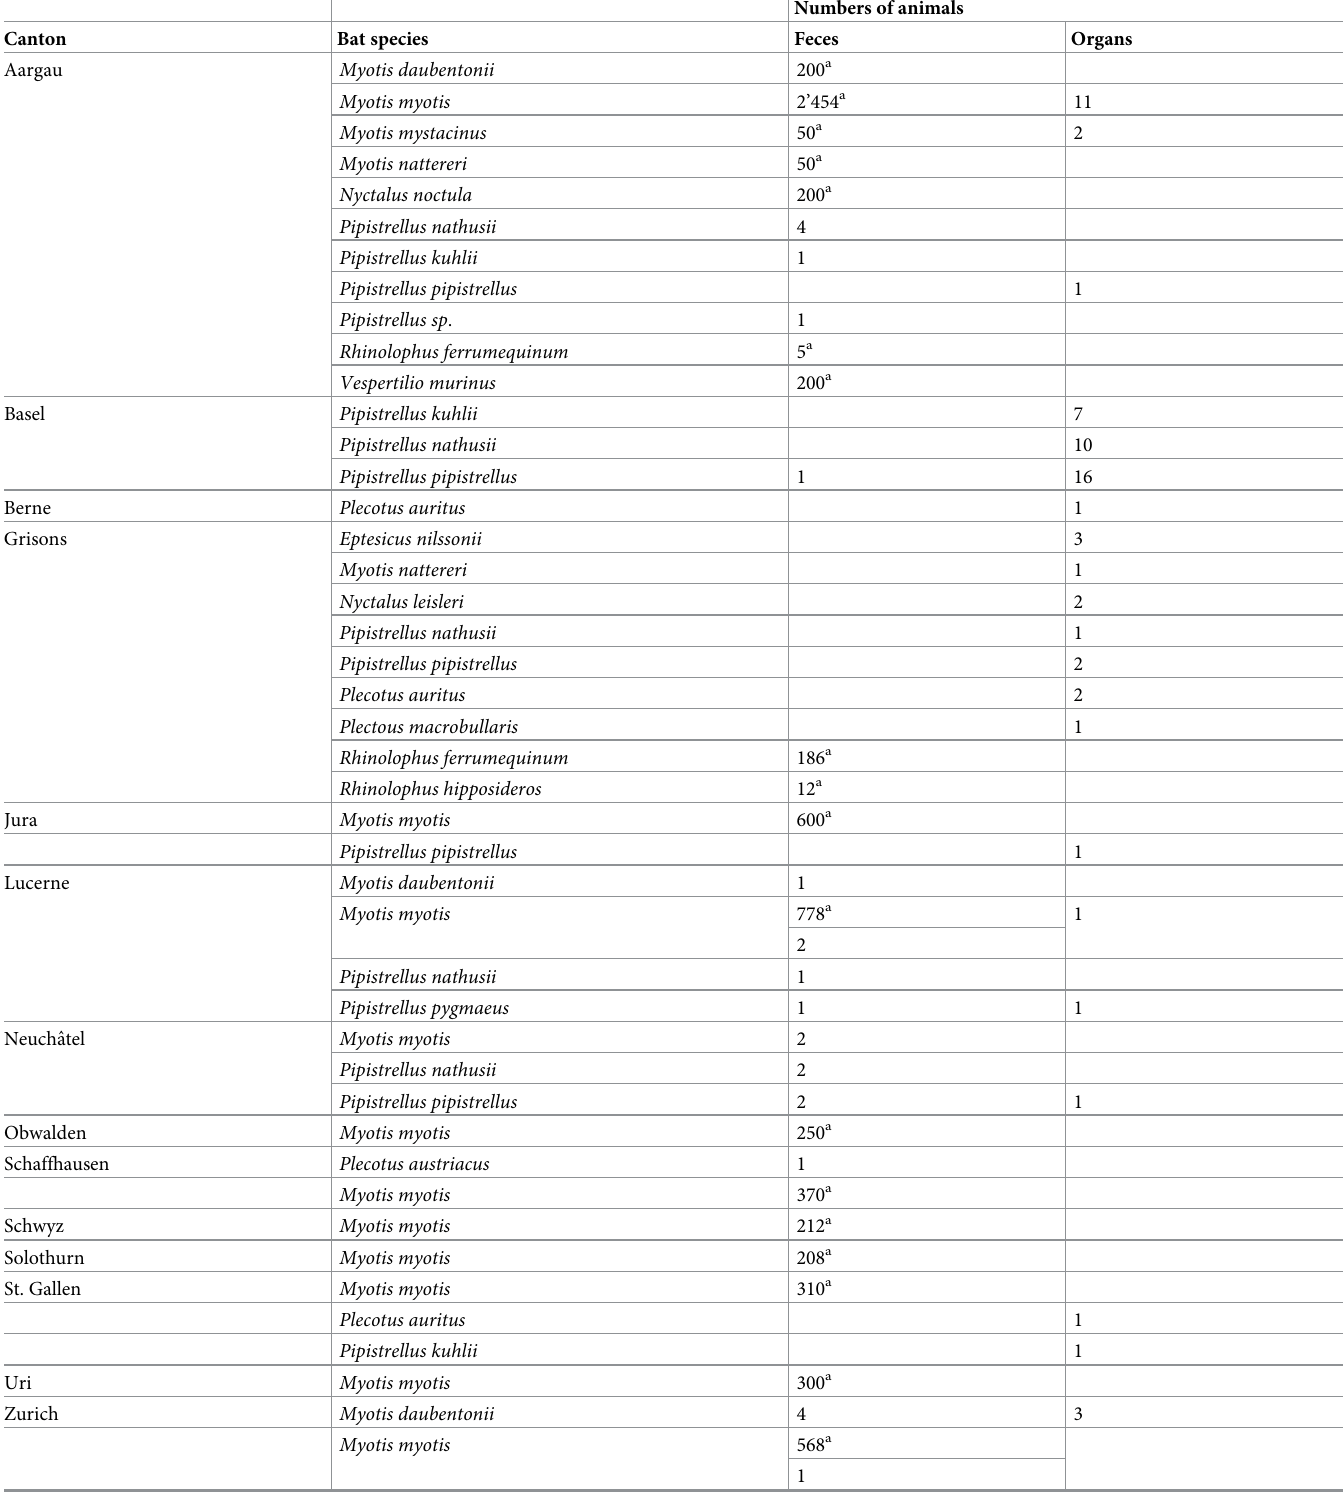
Table 1. Place of collection, bat species, numbers of bats, and samples collected in this study.